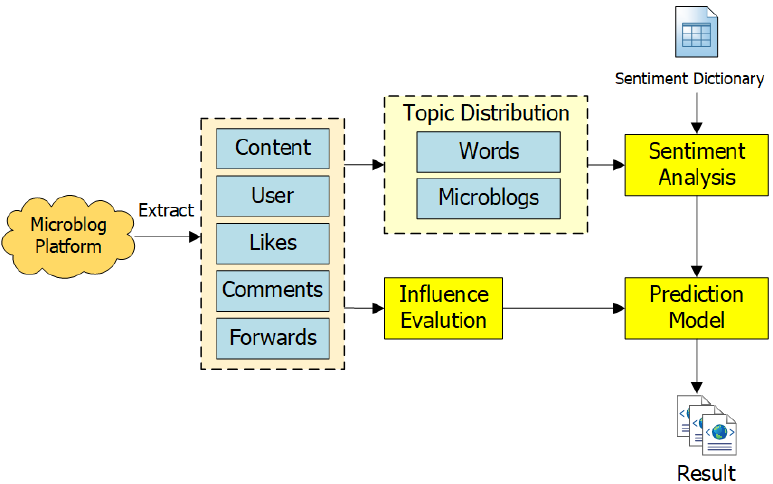
Figure 1. The architecture of microblog-based short-term sales prediction.